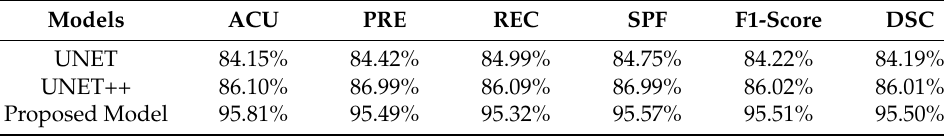
Table 5 . Comparison of the proposed model with UNET and UNET++ for the segmentation process.